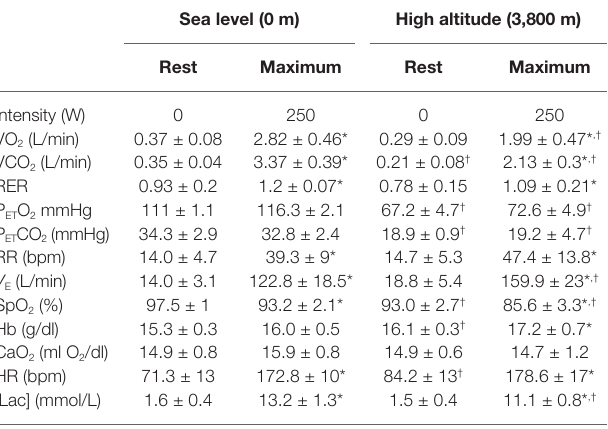
Values expressed as mean ± SD. *A significant difference between rest and maximum. † Significant difference between sea level and high altitude (p < 0.05).